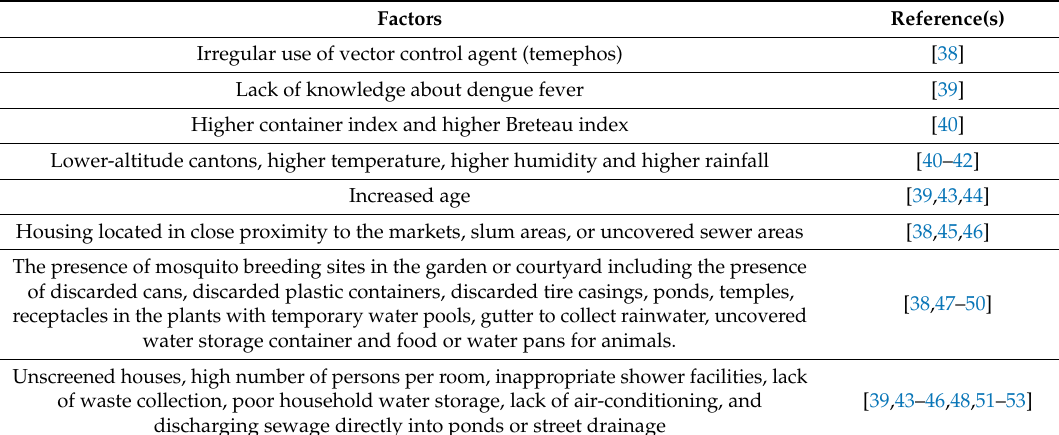
Table 2. Factors associated with dengue incidence or dengue